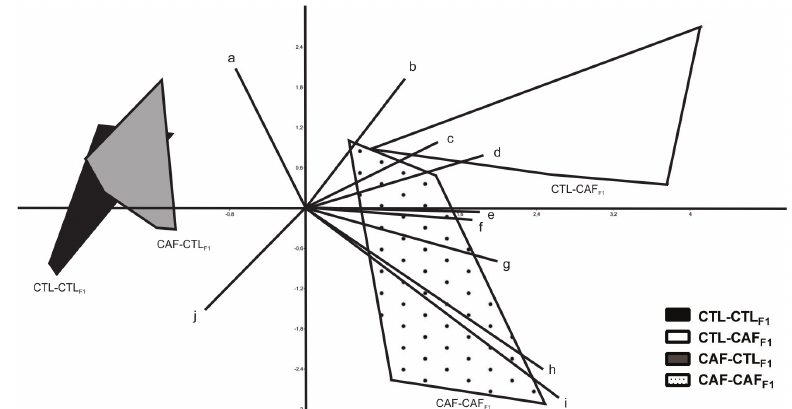
Figure 4 - Principal Component Analysis (PCA) Diagram. The letters in PCA represent a : Nucleus count in BAT; b : Adipocyte area in the WAT depot; c : Triglycerides; d : Body weight; e : Hepatic lipid accumulation; f : Glucose; g : Weight of WAT depot; h : Lipid droplets in BAT; i : Cholesterol; j : Adipocyte count in WAT depot. The number of animals analyzed was 5-7 rats per group from five different